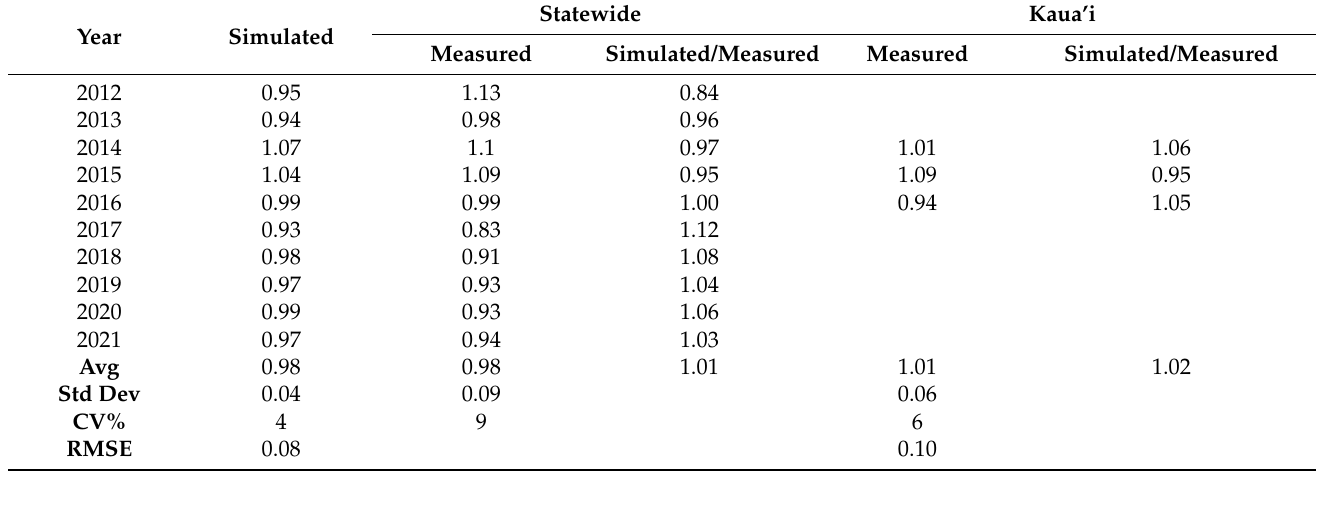
Table 7. Hawai’i simulated coffee yields and measured statewide averages in Mg/ha.